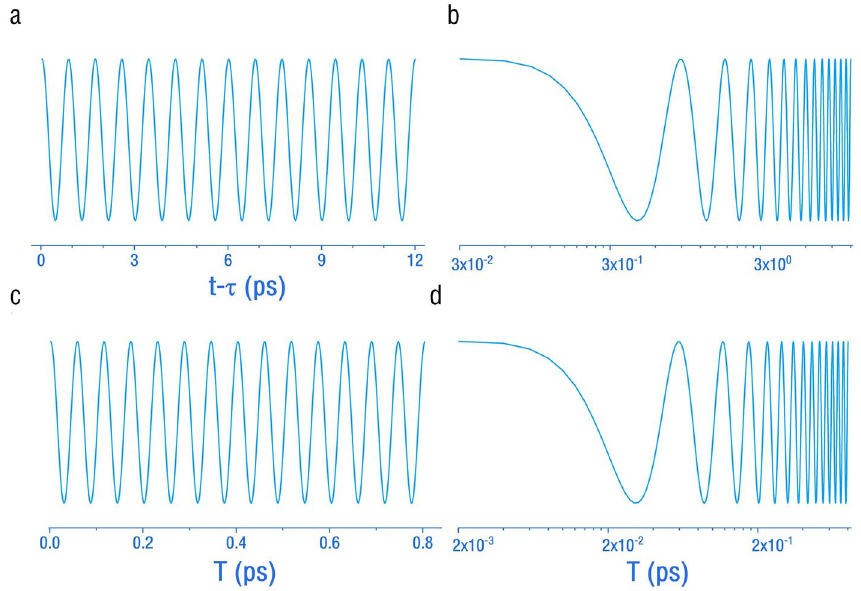
Figure 2. The oscillation behaviors of the interference intensity for electron-neutrinos. ( a ) A cross-section T , t τ in the ordinary time scale. ( b ) A similar plot but in a � τ , � k 2 line curve plot of cos versus t − − T , t � τ , � k 2 logarithmic time unit. ( c ) A cross-section line curve plot of cos versus T in the ordinary − (cid:31) (cid:30)(cid:30) (cid:31) time scale. ( d ) A similar plot but in a logarithmic time unit. Oscillations are present in both time directions, (cid:31) (cid:30)(cid:30) (cid:31) reflecting the mass oscillations induced by Heisenberg’s uncertainty principle. The oscillation period along t τ is found to be on the order of ps. −